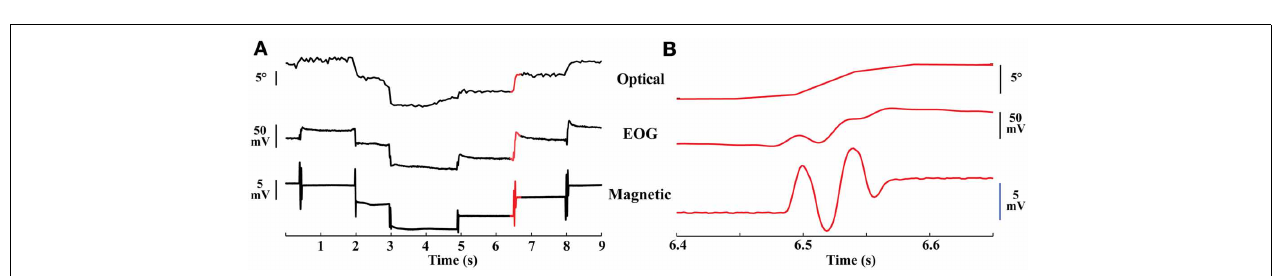
FIGURE 3 | Eye movements. (A) Simultaneous traces of optical, EOG, and magnetic recordings of eye movements from a head-immobilized bird. Upper trace: optical recordings of eye position. Middle trace: EOG recordings. Lower trace: magnetic recordings. The magnetic trace had a high SNR,